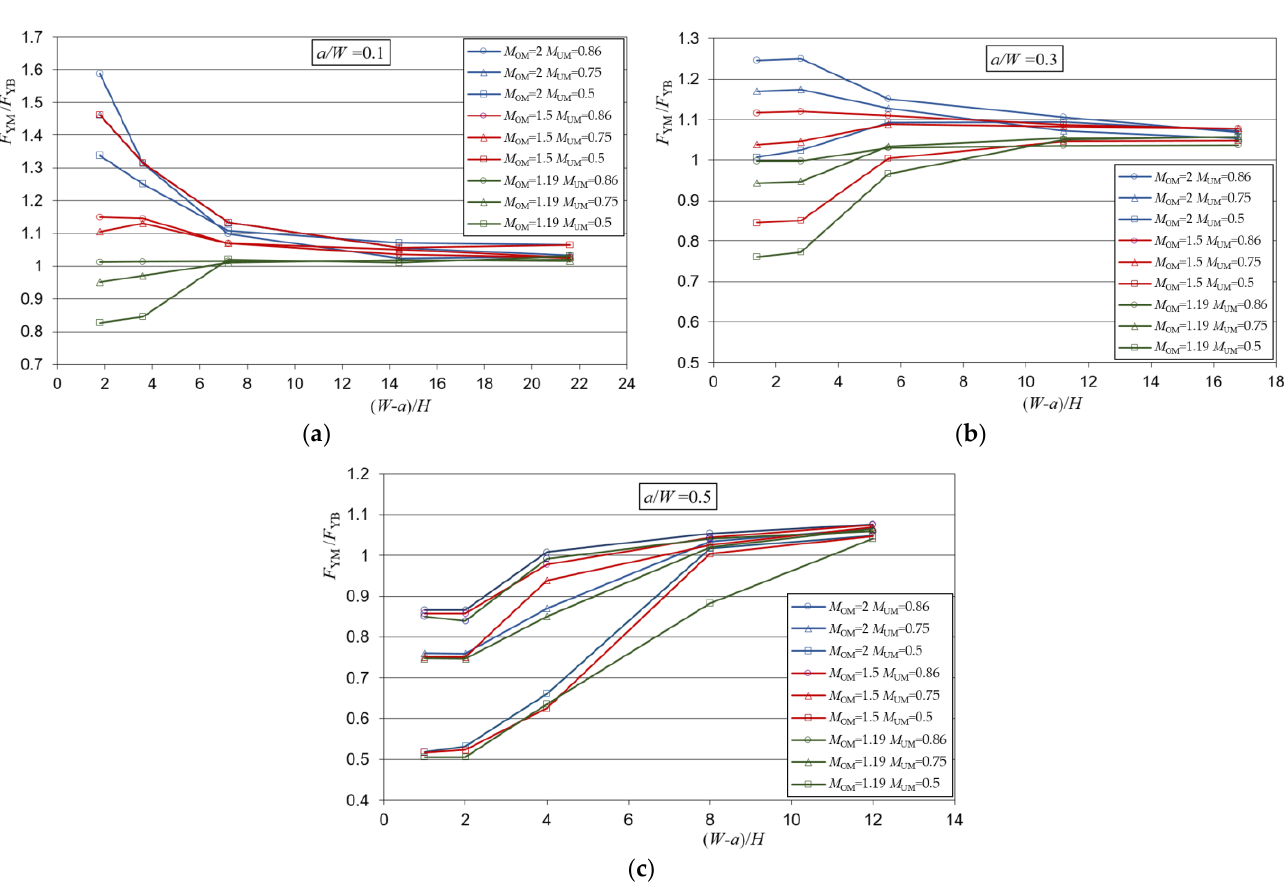
Figure 3. Dependence of weld slenderness ( W − a )/ H on weld width H and crack length a/W. 4.1. Yield Load Solutions for a Crack in the Over-Matched Part of the Weld Yield load solutions as a result of the analysis of a heterogeneous weld with a crack in the over-matched part of the weld in the function of weld slenderness ( W − a )/ H are presented in Figure 4.